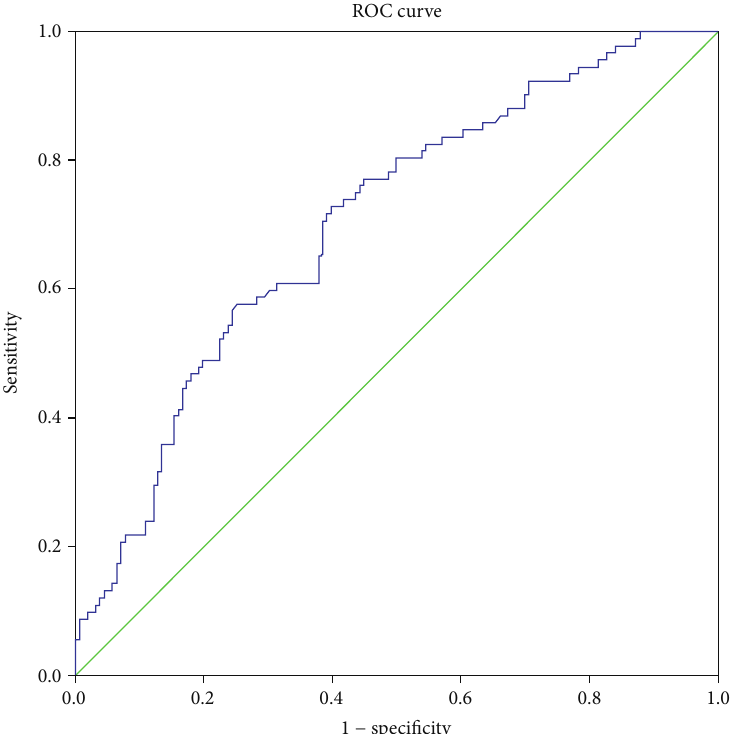
Figure 3: Receiver operating characteristic (ROC) curves for the ability of EDA to discriminate the presence of albuminuria. The ability of the ROC curve based on EDA levels to predict the presence of albuminuria was 0.701 (0.625-0.777). Optimal cuto ff points for EDA were 310.47pg/mL and sensitivity and speci fi city were 72.8% and 60.3%,